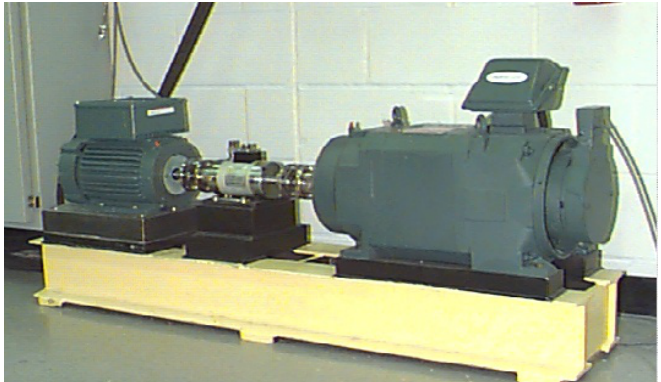
Figure 9. Testbed of CWRU.